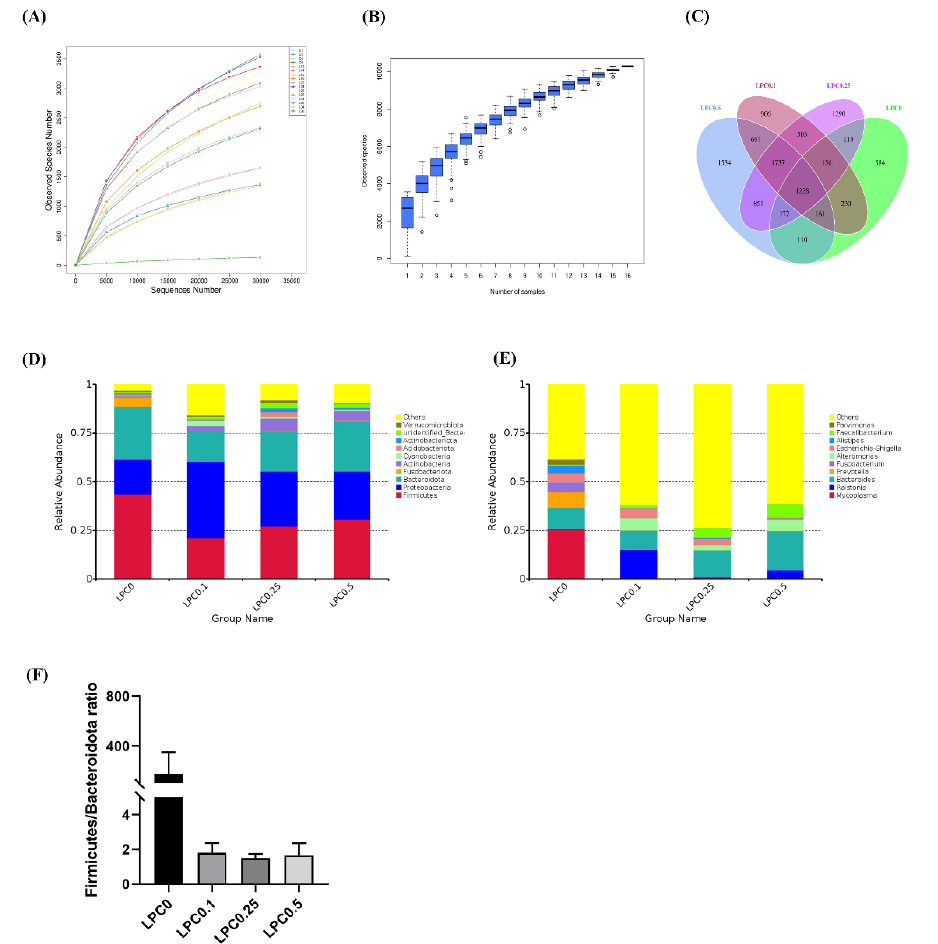
Figure 5. Taxonomy classification of reads at different levels ( n = 4). ( A ) Rarefaction curve; ( B ) Species accumulation boxplot; ( C ) Venn plot; ( D , E ) Bacteria taxonomic profiling at the phylum and genus level; ( F ) The Firmicutes/Bacteroides ratio.